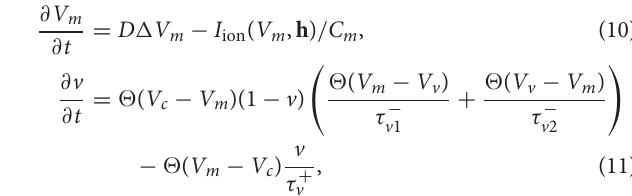
and to − π for times activated within τ before the upstroke.